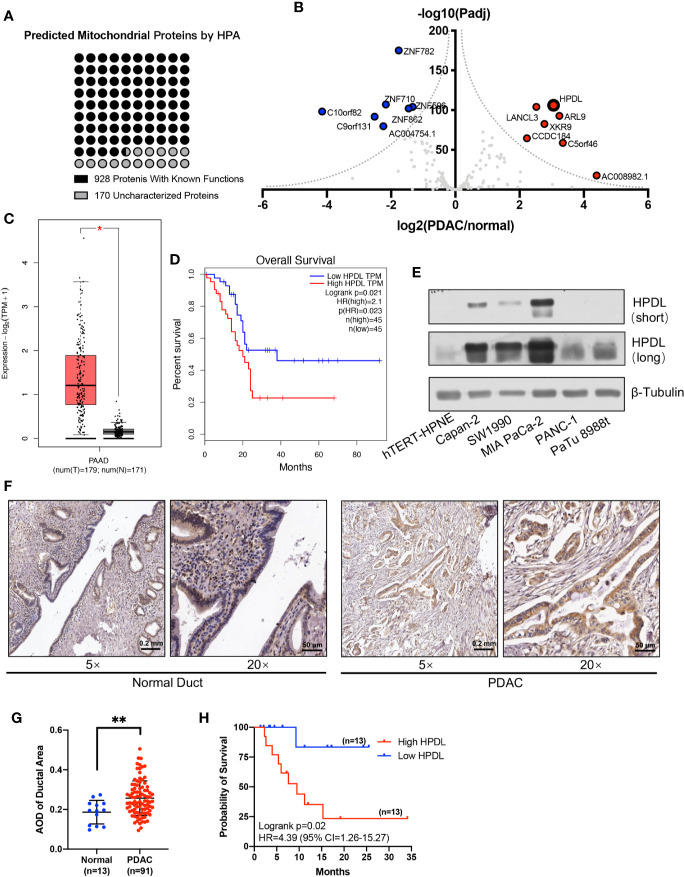
HPDL is upregulated in pancreatic ductal adenocarcinoma and associated with poor prognosis. (A) Mitochondrial proteins that experimentally detected in the mitochondria by the Human Protein Atlas (http://www.proteinatlas.org). The functional definitions of these mitochondrial proteins were based on the annotation of Uniprot (https://www.uniprot.org). (B) Gene expression profile of function-unknown mitochondrial proteins based on the data generated by the TCGA (https://www.cancer.gov/tcga) and GTEx (https://commonfund.nih.gov/GTEx) datasets. The genes were plotted with expression of PDAC/normal duct and adjusted p-value. The red points refer to genes up-regulated in PDAC and the blue points refer to genes down-regulated in PDAC. (C, D) Expression plot and survival plot of HPDL in pancreatic adenocarcinoma (PAAD) made by GEPIA server (http://gepia.cancer-pku.cn). For expression plot (C), threshold was set as follows: log2FoldChange <1, p-value <0.01. For survival plot (D), high and low expression groups were split by quartile, and the hazards ratio (HR) was calculated based on Cox PH model. (E) Western blot analysis of HPDL in different human pancreatic adenocarcinoma cell lines and human immortalized pancreatic duct cell line hTERT-HPNE. β-Tubulin was used as loading control. (F) Immunohistochemical (IHC) analysis of tissue microarray (TMA). TMA was incubated with anti-HPDL and stained with DAB and hematoxylin. HPDL expression in normal and malignant pancreatic ducts was shown in different zoom levels. (G, H) Quantitative analysis of HPDL expression in TMA. Quantification of HPDL expression was represented as average optical density (AOD). Comparisons between normal and malignant pancreatic ducts (G) was performed. Survival curve (H) was performed between low HPDL group and high HPDL group which were split by median. (*P < 0.05. **P < 0.01.)